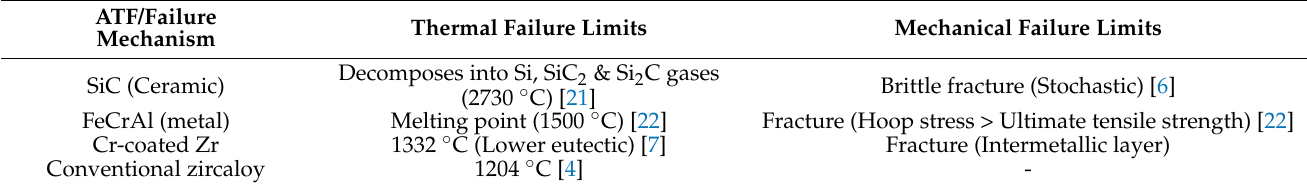
Table 1. Failure mechanism of ATF